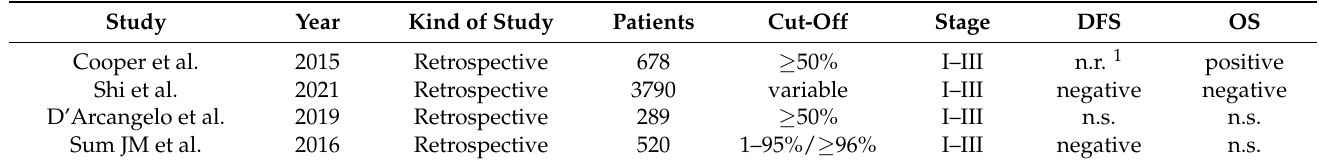
Table 4. Disease-free survival (DFS) and overall survival (OS) in early-stage NSCLC with PDL-1